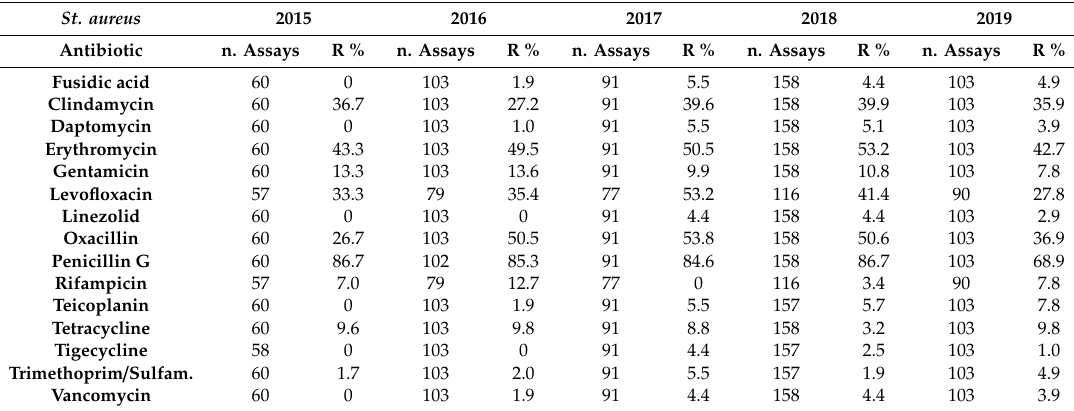
Table 2. Antimicrobial resistance profile of Staphylococcus aureus from patients with BSI to commonly used antibiotics.